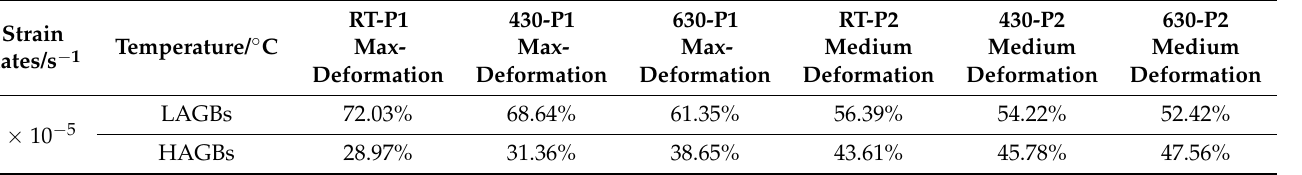
Table 2. The number of LAGBS and HAGBs under different temperatures at a strain rate of 5 × 10 − 5 s − 1 .